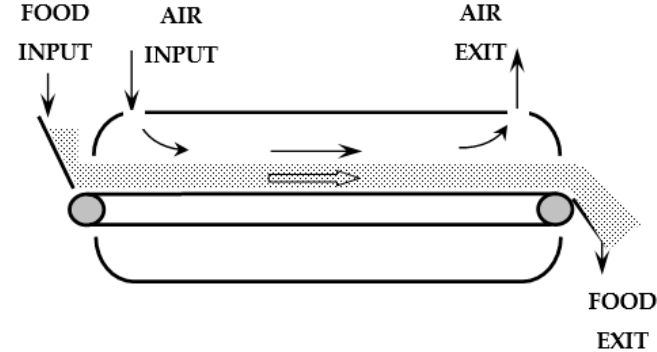
Figure 2. Conveyor-belt dryers with tangential flow (not perforated belt) for food drying.